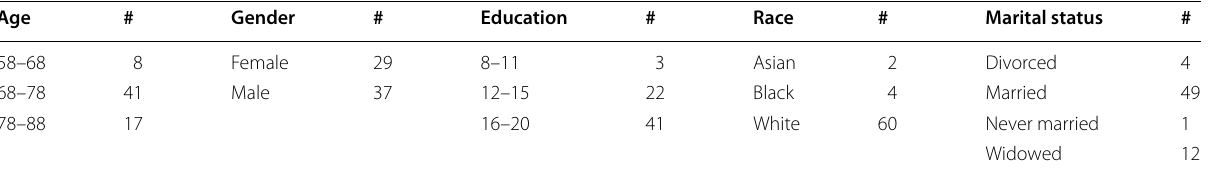
Table 1 Descriptive statistics of the 66 test dataset subjects